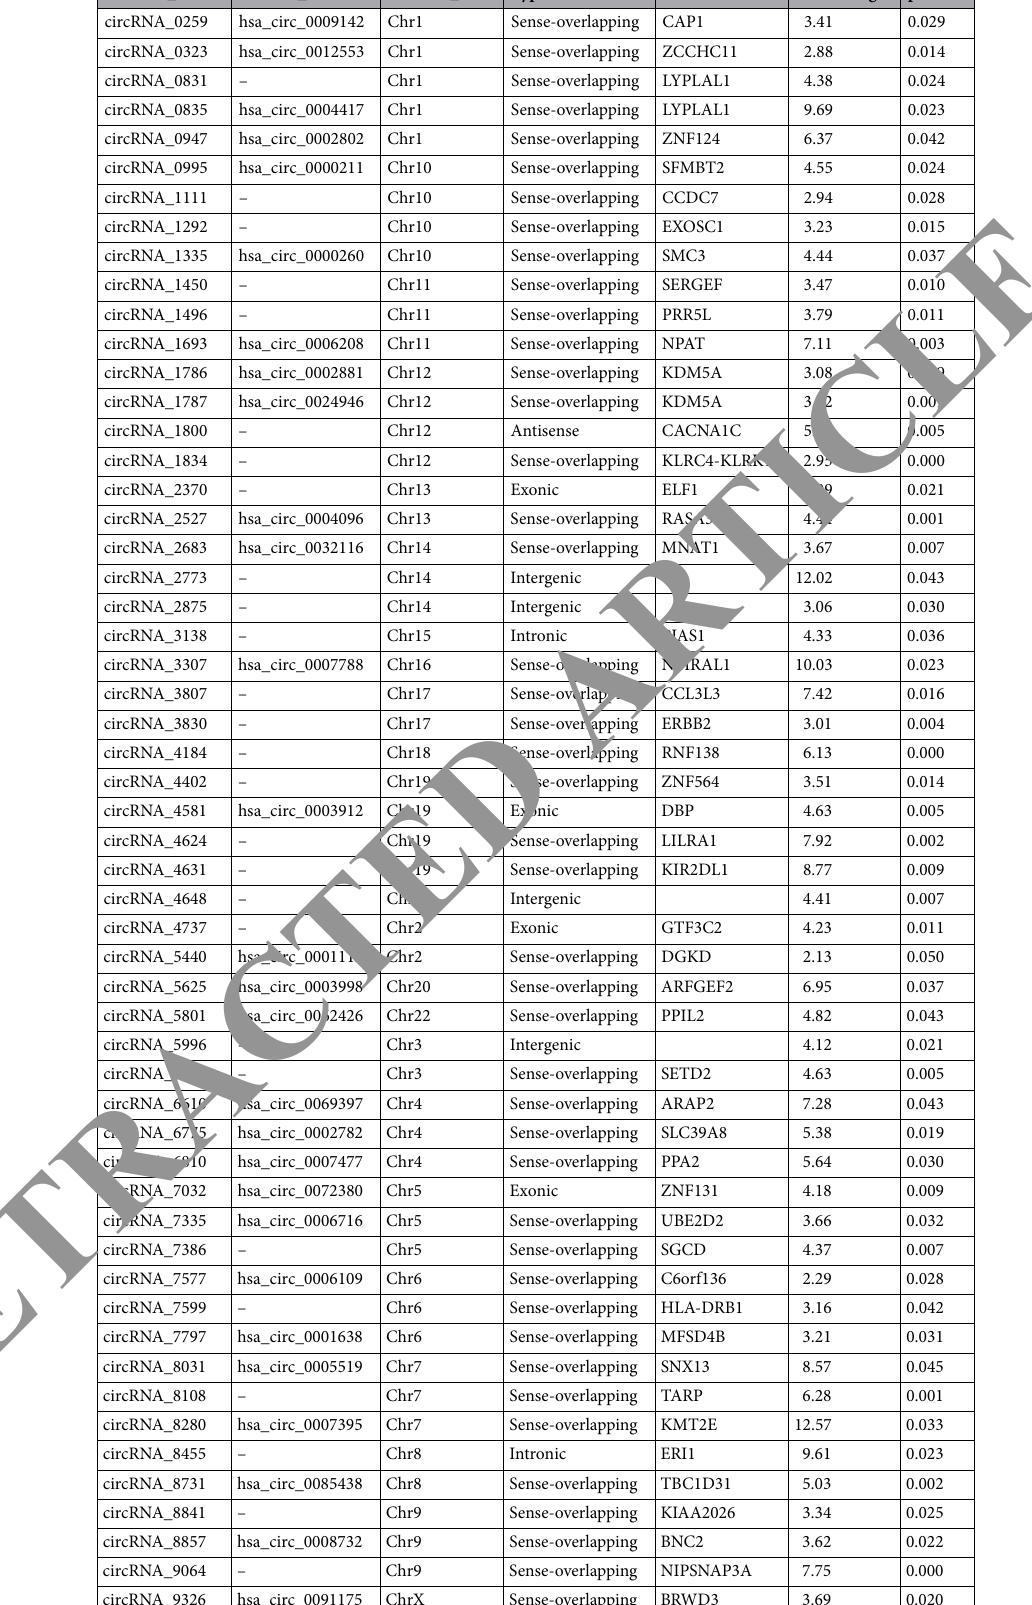
Table 4. Downregulation